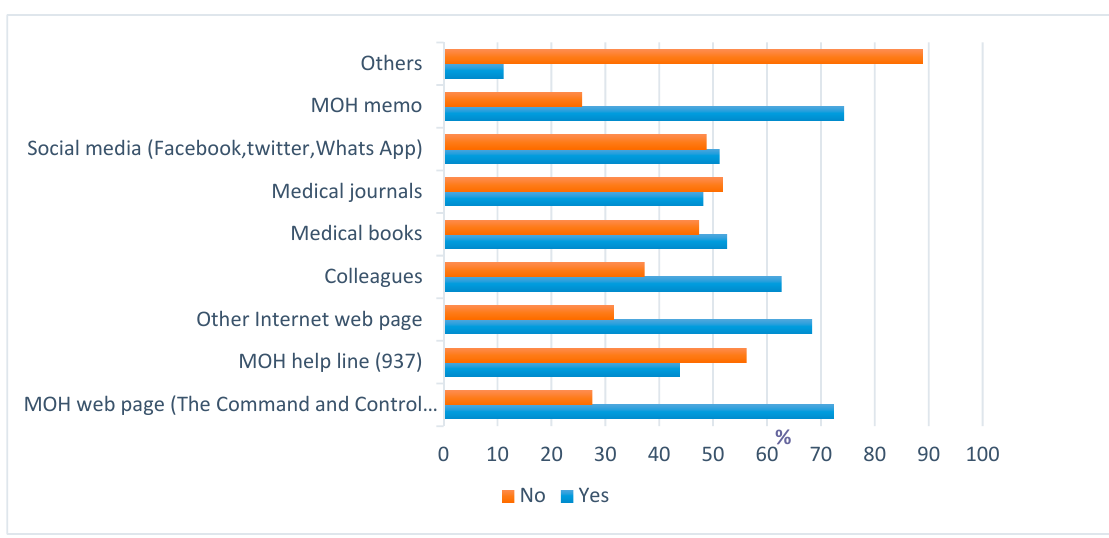
Figure 1. The most commonly used information sources of MERS-CoV by Healthcare workers (HCWs).